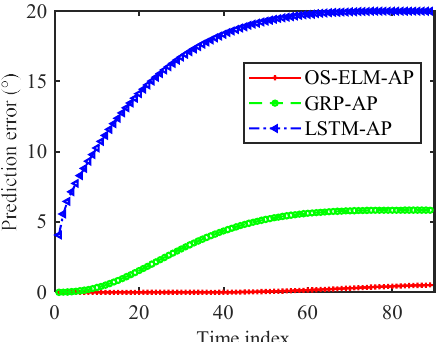
Figure 9. Online continuous multi-time angle prediction results.